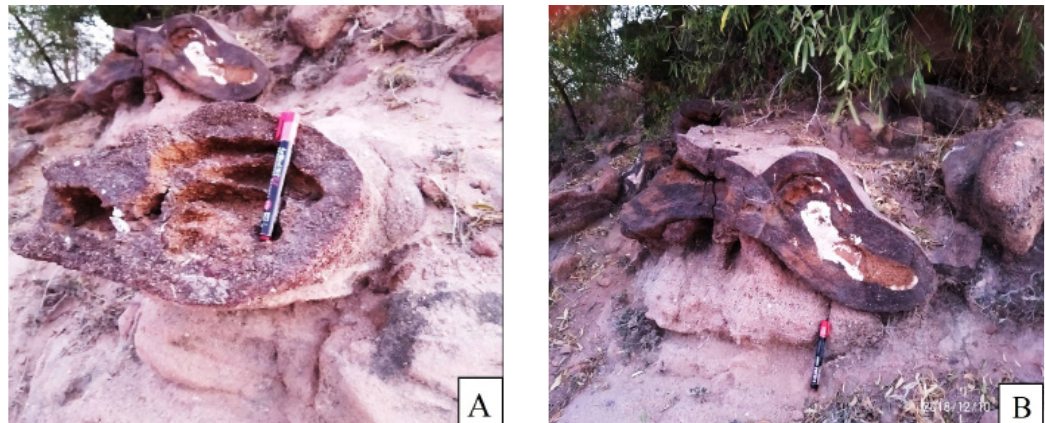
Figure 10. A and B) Petrified tree trunks in the Bhuj sandstone at